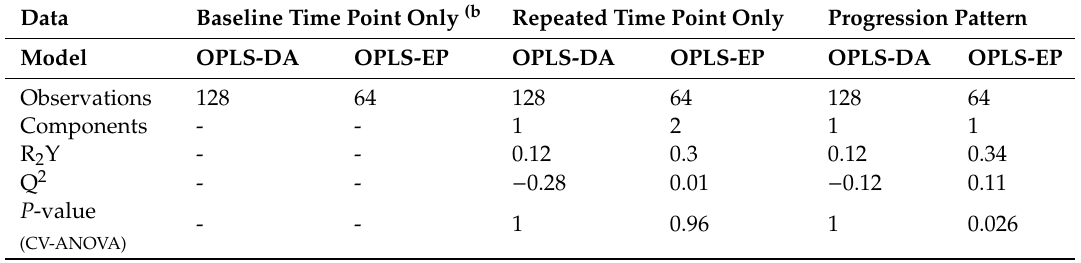
Table 1. Summary of OPLS-DA and OPLS-EP models based on metabolite data from longitudinally collected plasma samples from future glioma cases and their matched controls. The optimization done in each round of cross-validation was based upon multivariate significant variables w and p (a .